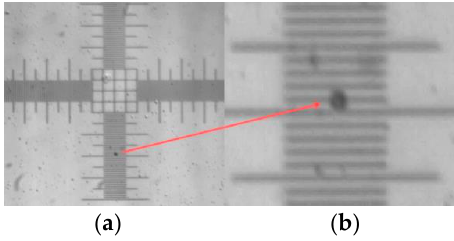
Figure 8. Microbubble image taken with a MIC-SLM-30 micropipette, ( a ) microbubble over the 1DIV/10 μm micrometric ruler and ( b ) enlarged microbubble image.